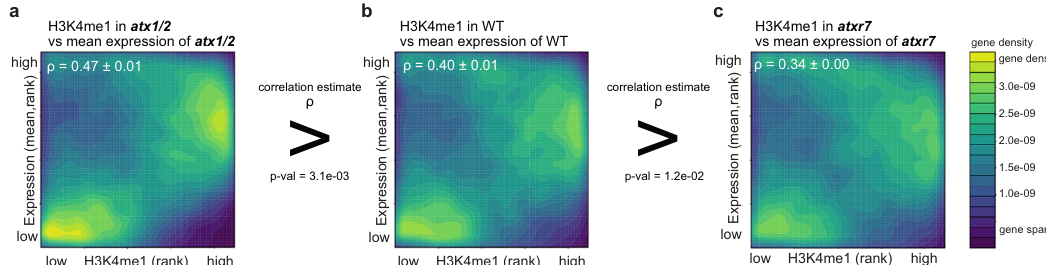
Fig.5|PositivecorrelationbetweentranscriptionandH3K4me1ismediatedby ATXR7and isdisturbedby ATX1/2. a – c Protein-coding genes areranked inorder ofH3K4me1( x -axis,RPKM)andexpressionlevels( y -axis,mRNA-seqFPKM,meanof the threeRNA-seqreplicates).The densities of genesarevisualizedas heatmaps. ρ is the Spearman ’ s correlationcoef fi cient. Three replicates ofmRNA-seq resulted in